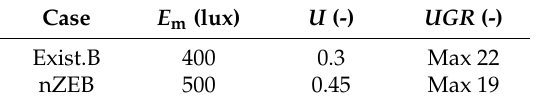
Table 8. Results of the lighting analysis for the existing and new electric lighting systems.